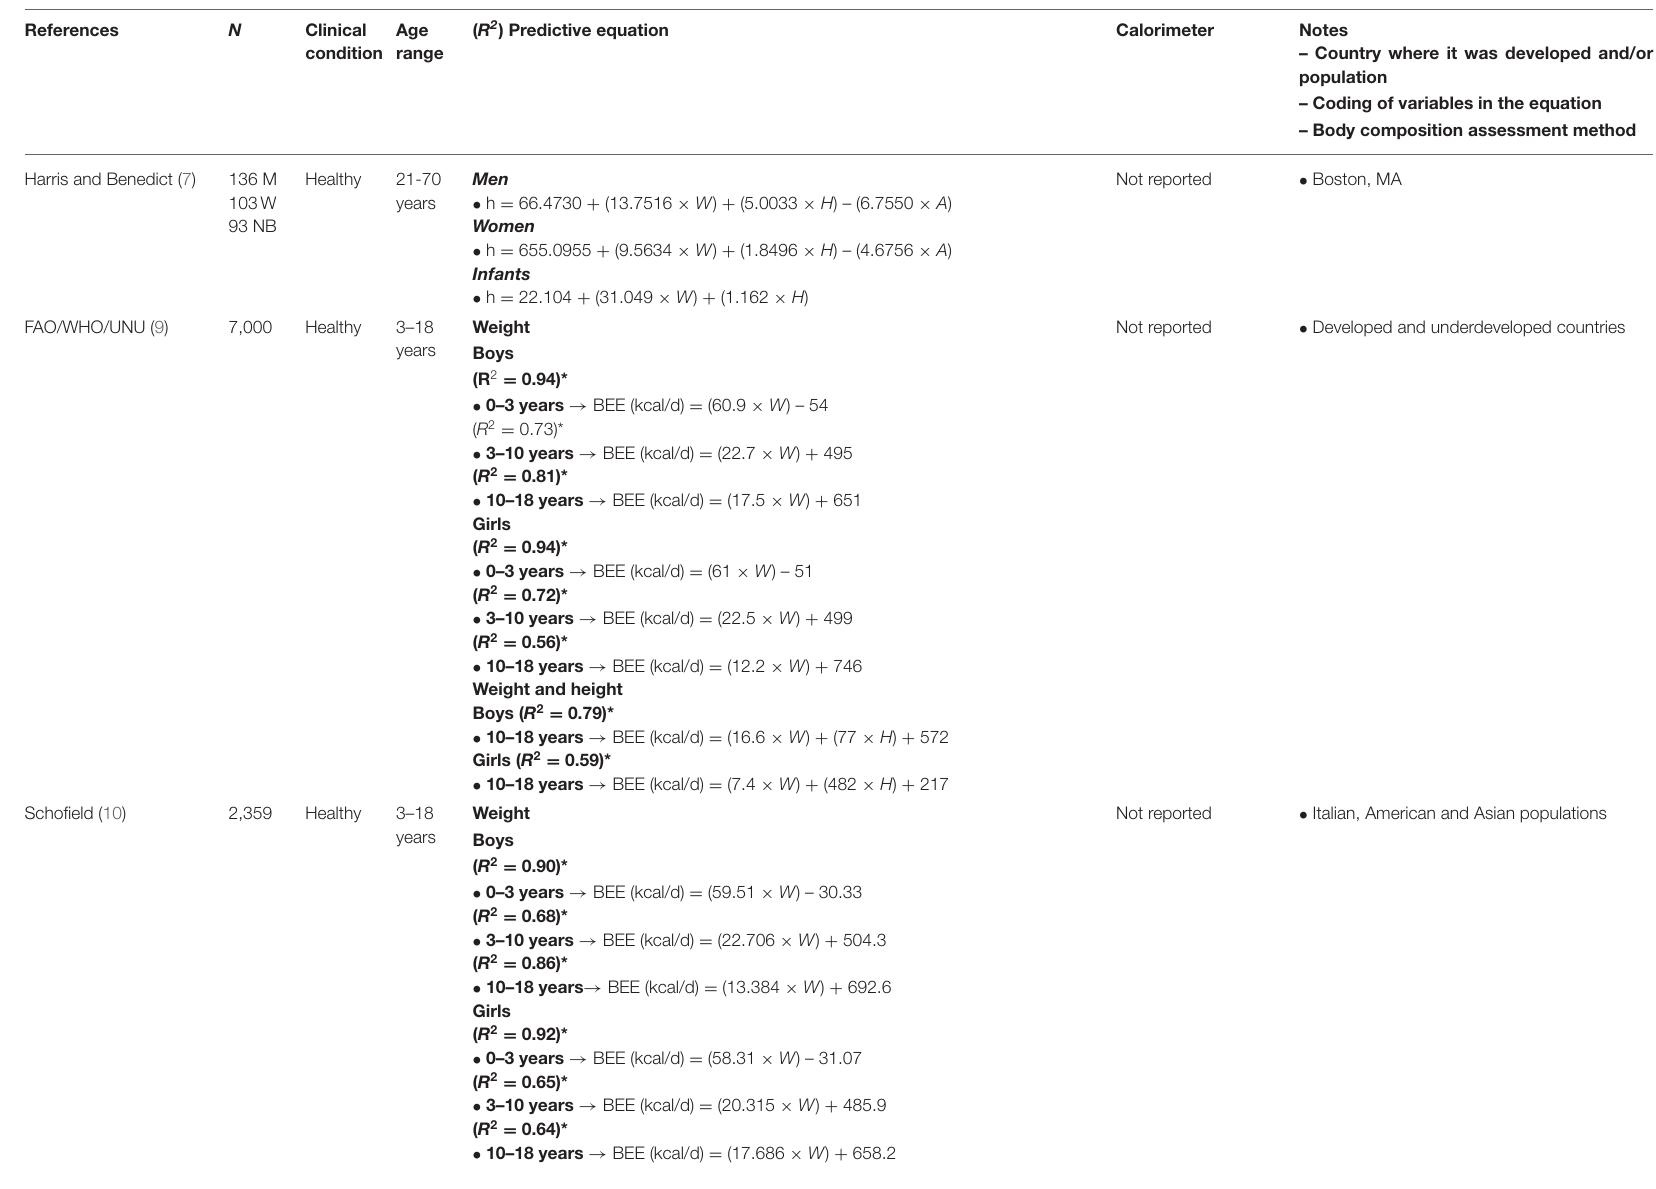
TABLE 2 | Equations for the prediction of energy expenditure in the healthy pediatric